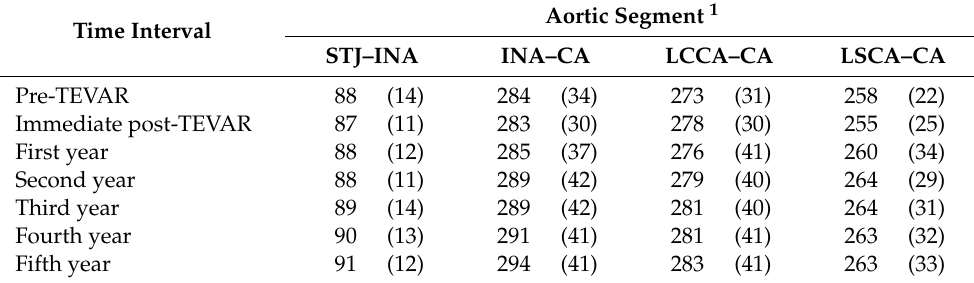
Table 2. Length of the aortic segment stratified by follow-up interval.